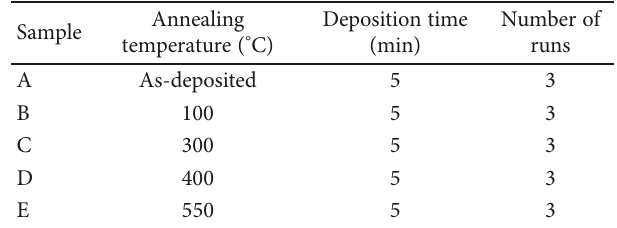
Table 1: Conditions for preparing the CdS fi